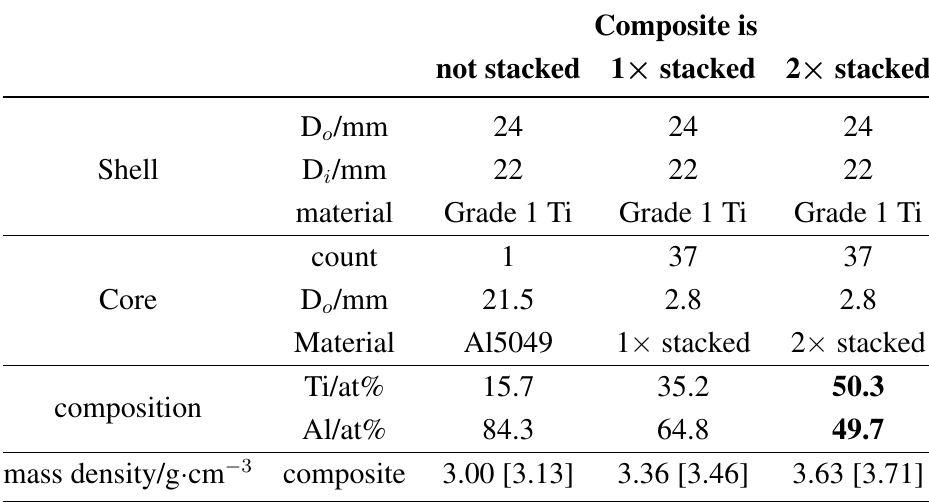
and D refer to outer and inner o i